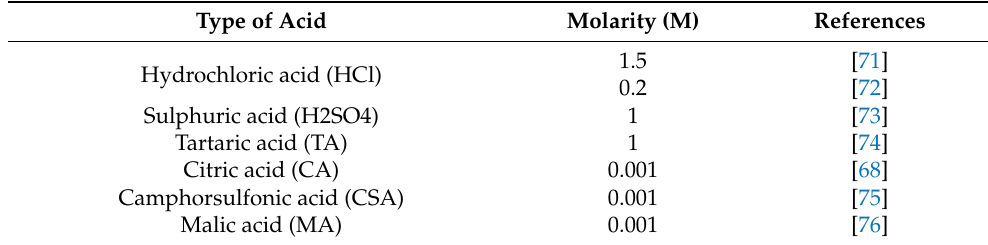
Table 2. Acid dopants with various molarity use for polymerization of